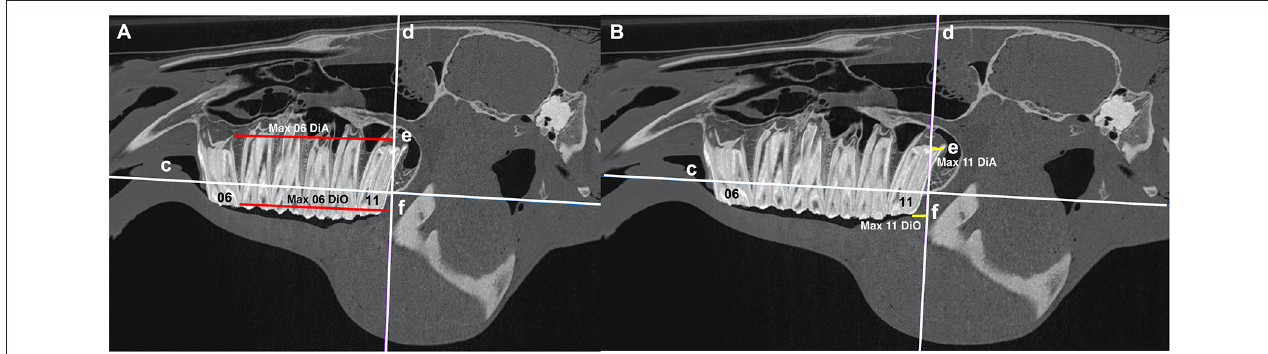
FIGURE 4 | (A) Sagittal CT image of an equine head showing line “c” that intersects the dorsal aspect of the maxillary bone immediately mesial to the maxillary second premolar (Triadan 06) tooth and the dorsal aspect of the maxillary bone immediately distal to the maxillary third molar (Triadan 11) tooth and line “d” at the level of the rostral orbit that lies perpendicular to line “c.” The red lines “e” (Max 06 DiA) and “f” (Max 06 DiO) run from line “d” to the distal aspect of the occlusal surface of Triadan 06 and to the distal aspect of the apex of Triadan 06, respectively. (B) Sagittal CT image of an equine head showing line “c” that intersects the dorsal aspect of the maxillary bone immediately mesial to the maxillary second premolar (Tridan 06) tooth and the dorsal aspect of the maxillary bone immediately distal to the maxillary third molar (Triadan 11) tooth and line “d” at the level of the rostral orbital rim that lies perpendicular to line “c.” The yellow lines “e” (Max 11 DiA) and “f” (Max 11 DiO) run from the line “d” to the distal aspect of the occlusal surface of Triadan 11 and to the distal aspect of the apex of Triadan 11, respectively.